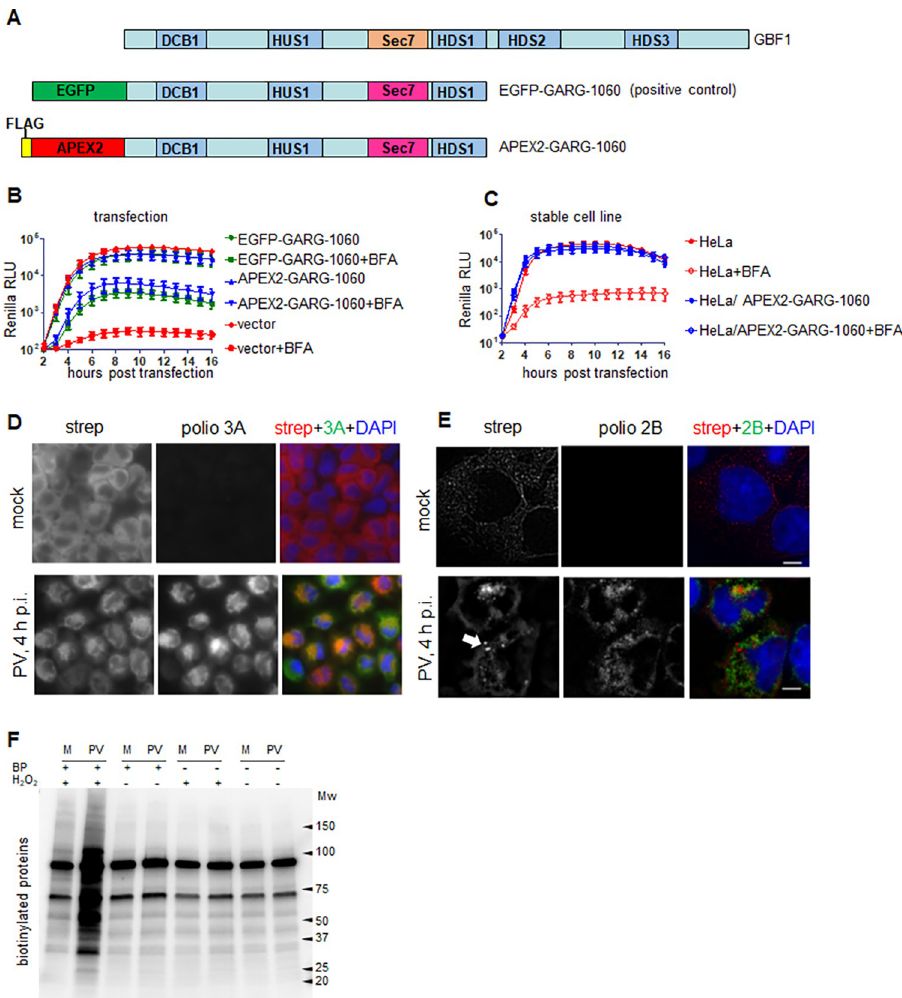
Fig 1. Characterization of the APEX2-GARG-1060 proximity biotinylation system. A. Domain organization of GBF1 and the C-terminally truncated GBF1 constructs fused to EGFP (positive control) and APEX2. Both GBF1 truncated constructs contain the BFA-resistant Sec7 domain from ARNO. B. Polio replicon replication was assessed in the presence or absence of 2 μ g/ml of BFA in HeLa cells transfected with plasmids expressing the C-terminally truncated GBF1 fusions with APEX2 or EGFP, or an empty vector C. Polio replicon replication assay was performed in control HeLa cells, or HeLa cells stably expressing APEX2-GARG-1060 with or without 2 μ g/ml of BFA. D. HeLa cells stably expressing APEX2-GARG-1060 were infected (or mock-infected) with 10 PFU/cell of poliovirus, and the biotinylation reaction was performed at 4 h p.i. The cells were processed for visualization of biotinylated proteins with a fluorescent streptavidin conjugate and immunostaining for a poliovirus antigen 3A. E. HeLa cells stably expressing APEX2-GARG-1060 were infected (or mock-infected) with poliovirus and the biotinylation reaction was performed as in D. The cells were stained with a fluorescent streptavidin conjugate and antibodies against a poliovirus antigen 2B and processed for structural illumination superresolution (SIM) microscopy. The arrow shows biotinylation-positive structures identified as stress granules. The scale bar is 10 μ m. F. HeLa cells stably expressing APEX2-GARG-1060 were infected (PV), or mock-infected (M) with 10 PFU/cell of poliovirus, and protein biotinylation was assessed after performing the biotinylation reaction at 4 h p.i. with biotin-phenol (BP) and hydrogen peroxide (complete reaction), or without one, or both compounds. To characterize the specificity of the biotinylation reaction, cells were similarly infected (or mock-infected), and at 4 h p.i. incubated either with both H O and biotin-phenol, or with 2 2 H O or biotin-phenol only, or without any of those compounds. Western blot analysis with 2 2